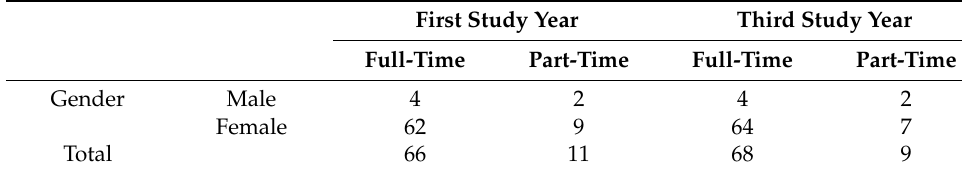
Table 1. Distribution of students by gender, year of study, and study